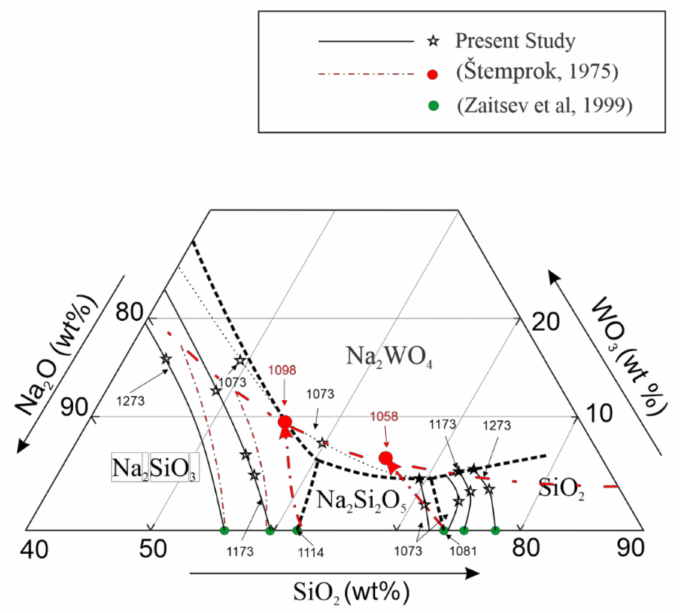
Figure 5. Comparison of the phase diagram between the present study and previous results [19,25], temperature in